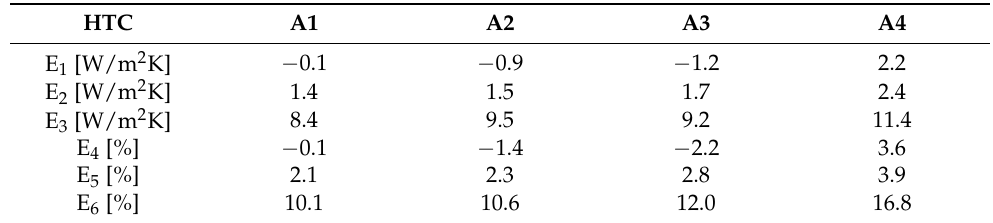
Table 15. Values of estimates E 1 –E 6 for HTC (20)–(25) with heating process p4 in planes